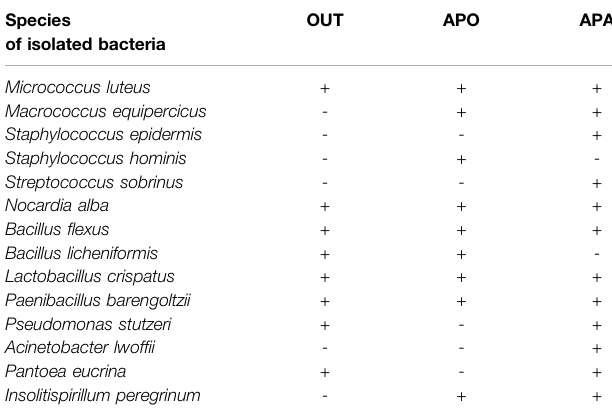
TABLE 4 | Bacterial species identi fi ed inside nursery school during two cycles: when APO/when APA and outdoor